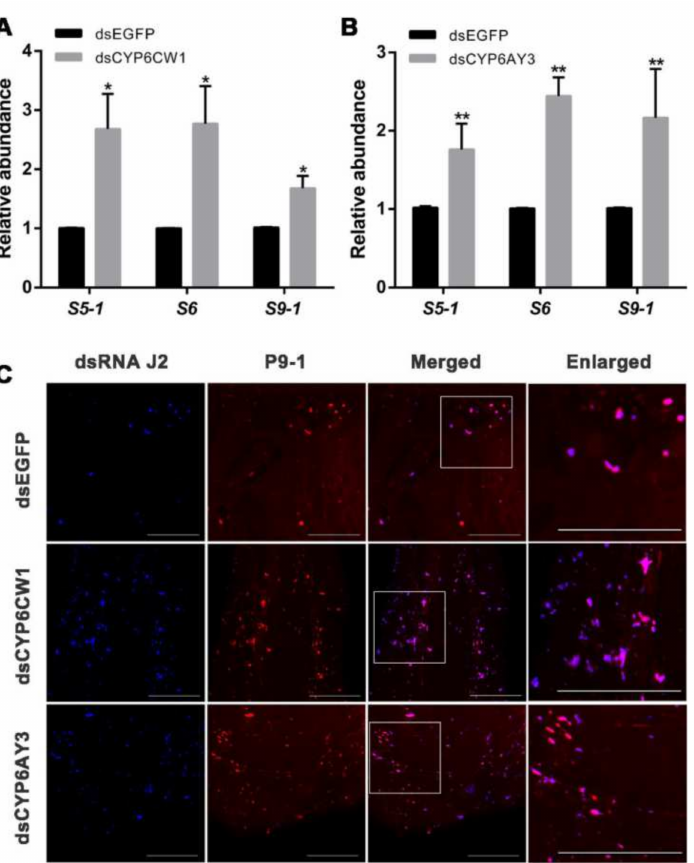
Figure 6. Knockdown of CYP6CW1 and CYP6AY3 increased RBSDV replication in L. striatellus . ( A , B ) RBSDV-infected L. striatellus were injected with the dsRNAs. The expression level of RBSDV S5-1 , S6, and S9-1 in L. striatellus knocked down of CYP6CW1 ( A ) and CYP6AY3 ( B ) were analyzed by RT-qPCR three days after injection. ( C ) The P9-1 protein and dsRNA, which are involved in virus replication, were labeled in the L. striatellus knocked down of CYP6CW1 and CYP6AY3 using P9-1 and dsRNA J2 antibody by immunofluorescence analysis. The asterisk (*) and asterisks (**) indicate p < 0.05 and p < 0.01. Scale bars, 50 µ